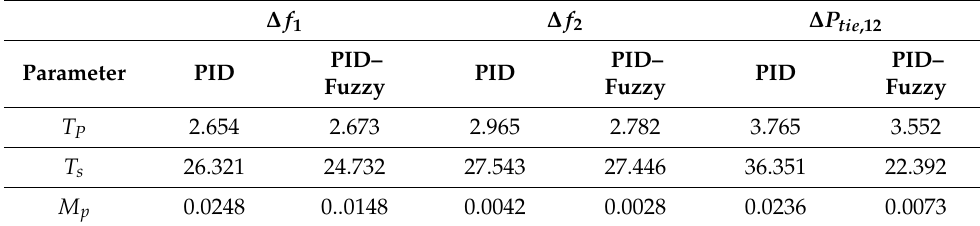
Table 6. Case 2: dynamic performance characteristics of the two controllers for a 0.2 pu change in area 2.